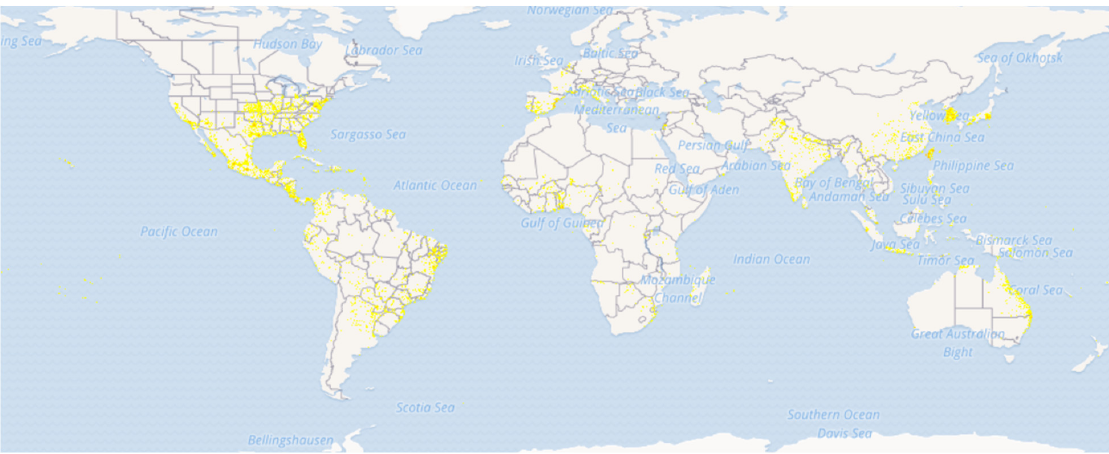
Figure 2. Distribution map of Eclipta prostrata. (Source: GBIF, https://www.gbif.org/species/5384950 (accessed on 1 November 2021) [15]).